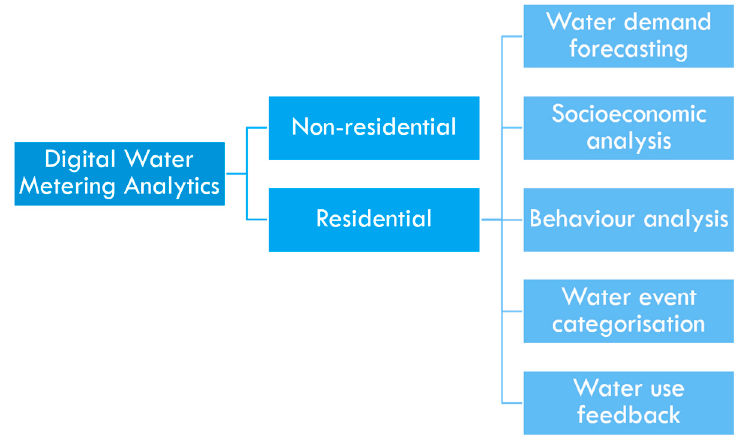
Figure 2. Comprehensive themes of literature on residential digital water metering.